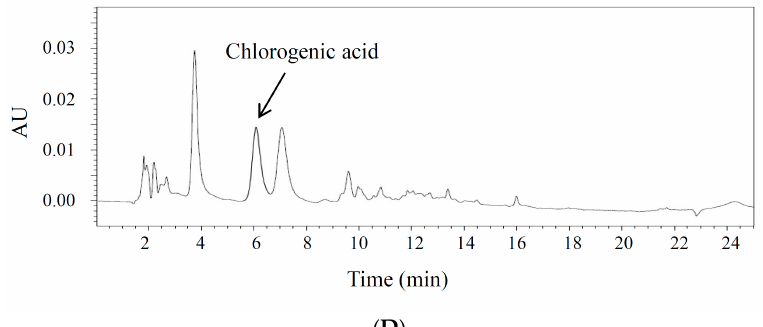
Figure 1. Identification of active compounds in C. tricuspidata leaf and fruit extracts by high-performance liquid chromatography (HPLC) analysis. ( A ) Chemical structures of chlorogenic acid, rutin, and kaempferol; ( B ) standard mixture at 340 nm; ( C ) sample extract (leaf) at 340 nm; ( D ) sample extract (fruit) at 340 nm. A mobile phase consisting of a mixture of solvent A (acetonitrile) and B (water containing 0.2% phosphoric acid) and employing a gradient elution (from 10:90 to 100:0 v / v ) was run at a flow rate of 0.8 mL/min.